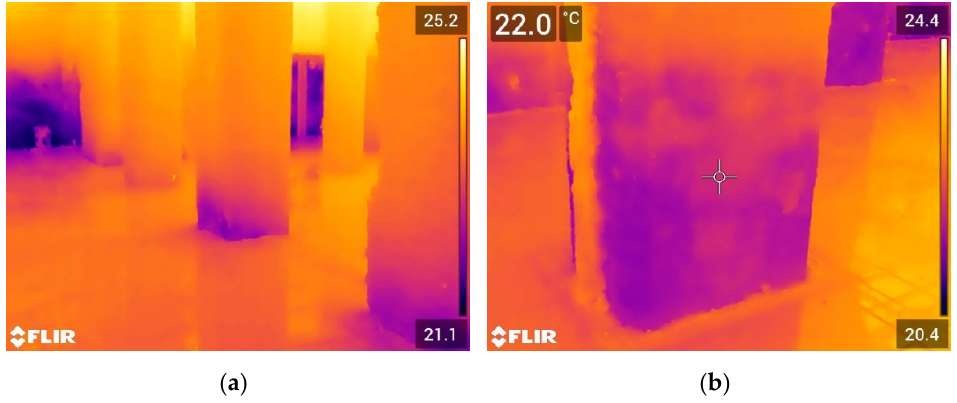
Figure 6. Thermal images of internal pillars: ( a )—several pillars, ( b )—single pillar.